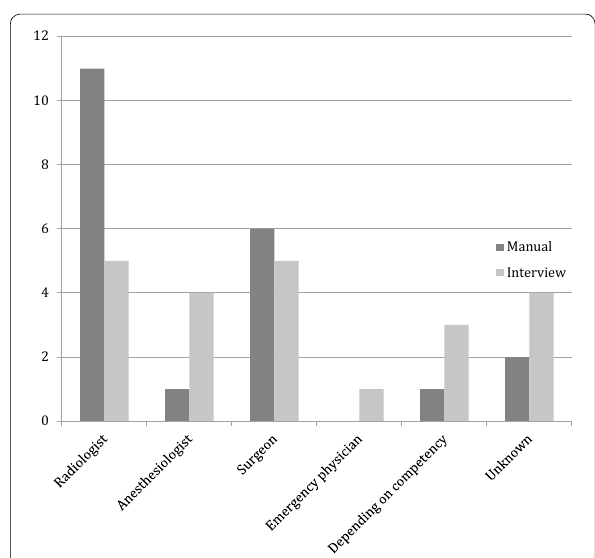
Fig. 2 Specialties performing FAST. Specialties performing FAST examinations in trauma according to trauma care manuals and inter- views with trauma